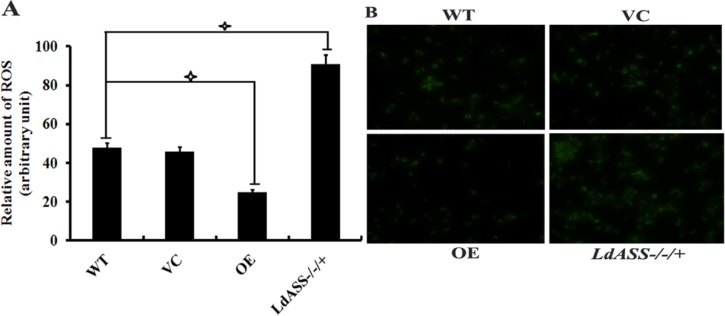
Measurement of ROS level.ROS level in different L. donovani cell lines (WT, VC, OE and LdASS-/-/+) were determined both by spectroflurometry and fluorescence microscopy using H2DCFDA. The promastigotes were first treated with menadione and incubated with H2DCFDA for the estimation of ROS level. A) The ROS level was found to be decreased by ~1.9 fold in OE cells whereas increased by 1.8 fold in LdASS down regulated cells (LdASS-/-/+) compared to WT cells. Each measurement was performed in triplicate and data are expressed as the mean. Vertical lines on top of the bars represent s.e. values and star symbol above the vertical lines denotes significant changes with P<0.005. B) The fluorescence microscopy images showed that greater fluorescence intensity in LdASS down regulated cells whereas lower intensity in OE cells compared to WT cells.